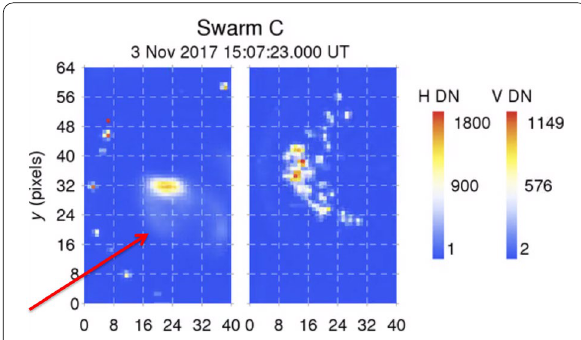
Fig. 9 Classic wing anomaly (red arrow) and peripheral anomalies (islands of concentrated signal in the left panel) in raw Swarm C horizontal TII imagery (left panel) on 3 November 2017. The noisy signal at right (vertical sensor) is associated with low input